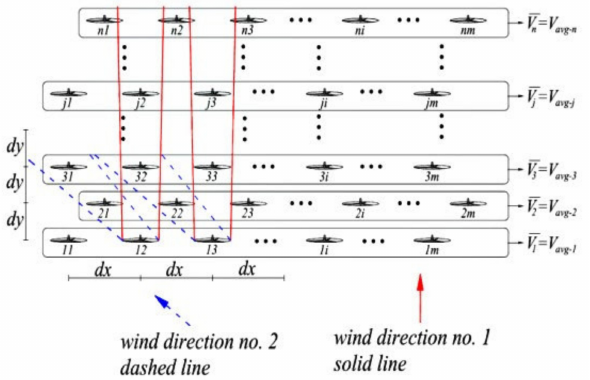
Figure 3. The effect of wind direction on the wake effect by upstream wind turbines for two different wind directions